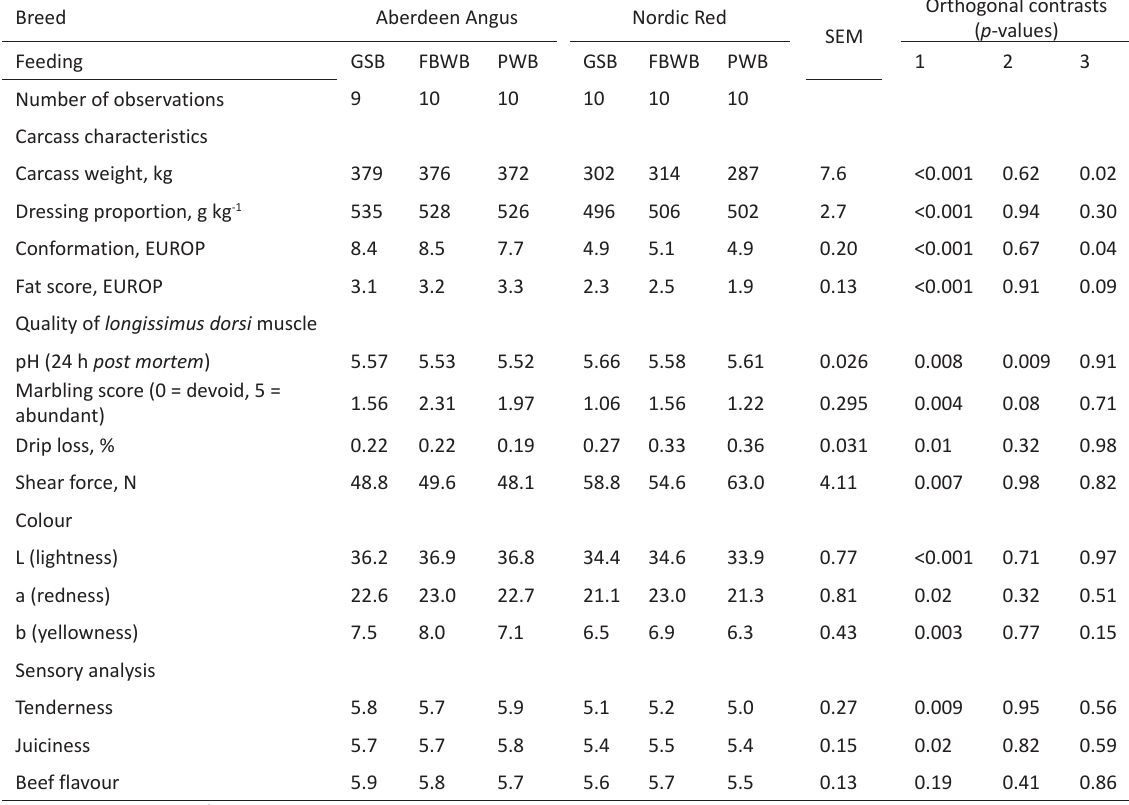
Table 3. Carcass traits and meat quality ( M. longissimus dorsi ) of the bulls fed different total mixed rations Breed Aberdeen Angus Nordic Red